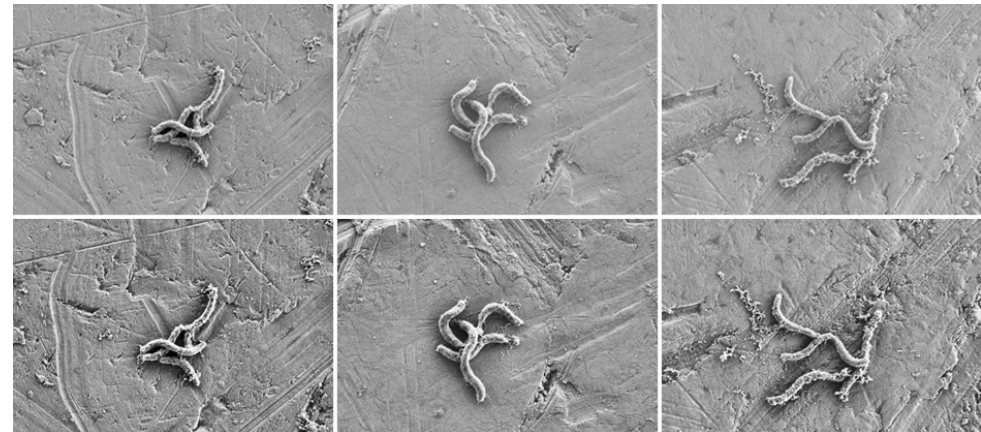
Figure 2. Sample SEM images from the dataset. The first row shows the raw SEM image and the second row shows the corresponding contrast enhanced